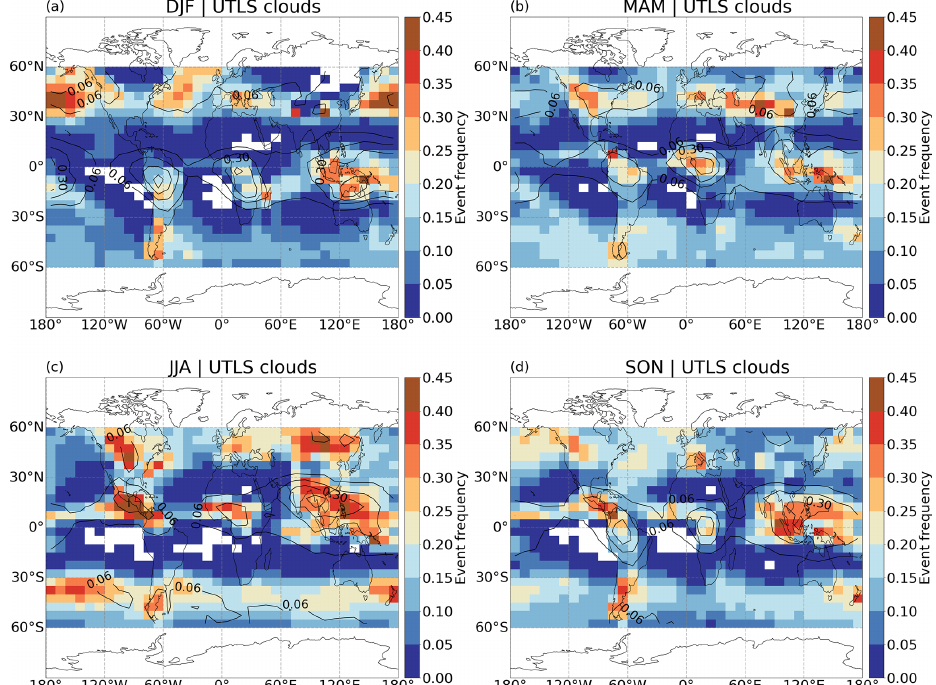
Figure 5. Seasonal event frequency of UTLS clouds derived from AIRS during 2007–2019. Occurrence frequencies of SICs (data in Fig. 1a– d) are shown as black contours with an interval of